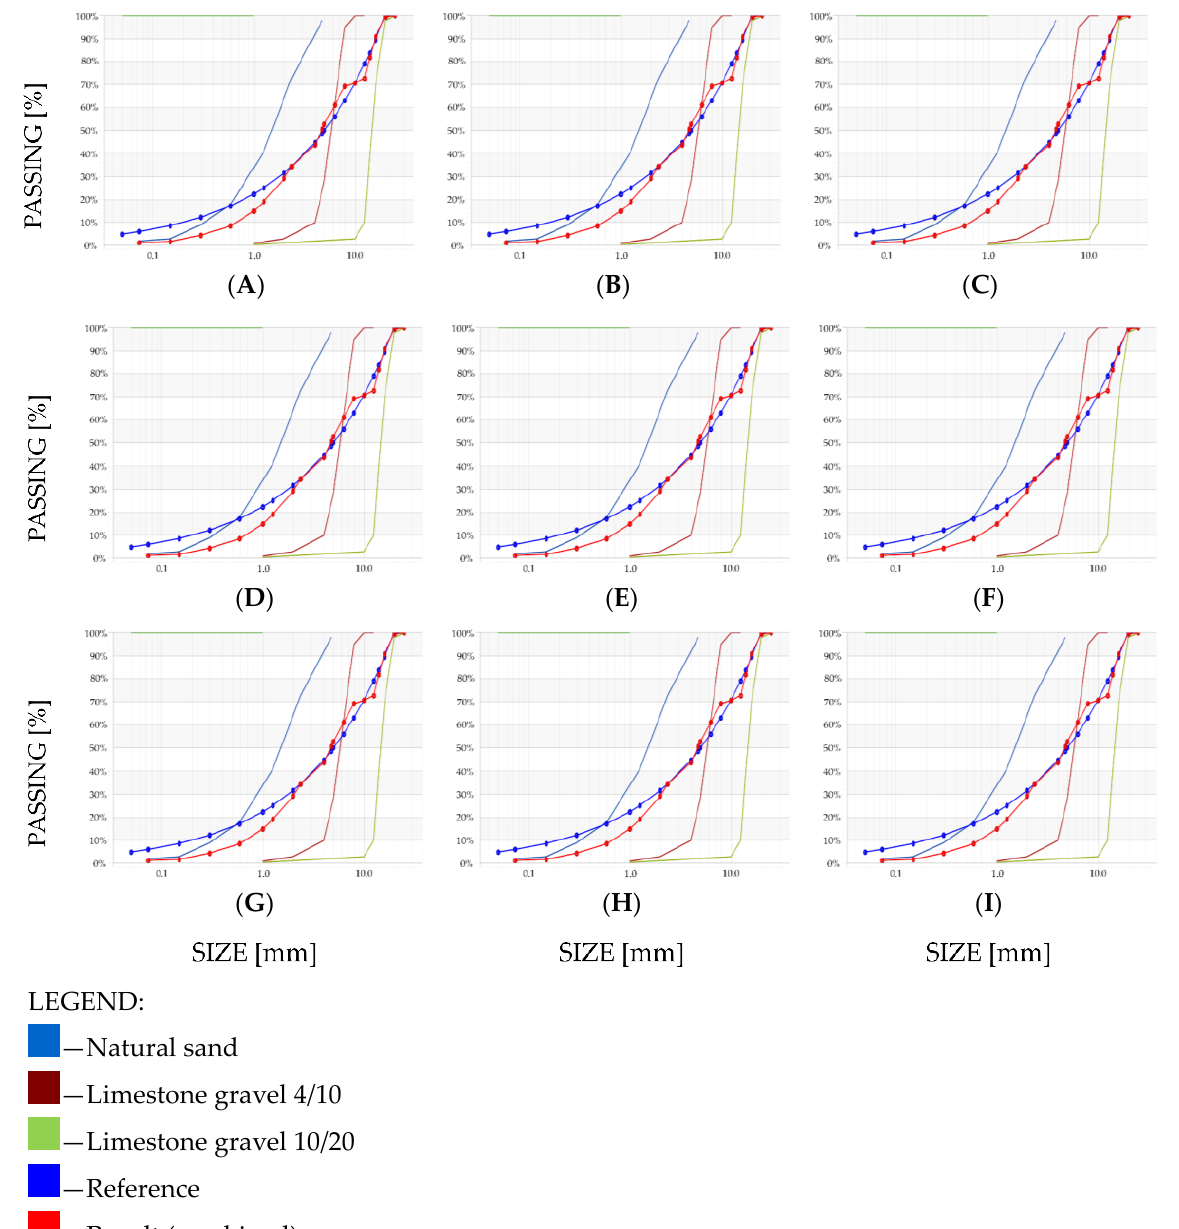
Figure A7. Gradings and fitting curves for Recipe #4—standard mix with plasticizer (lignosulfonate) and superplasticizer (naphthalene) designed according to the Bolomey Method: ( A ) 10 MPa; ( B ) 15 MPa; ( C ) 20 MPa; ( D ) 25 MPa; ( E ) 30 MPa; ( F ) 35 MPa; ( G ) 40 MPa; ( H ) 45 MPa; ( I ) 50 MPa. Legend in the left bottom corner.